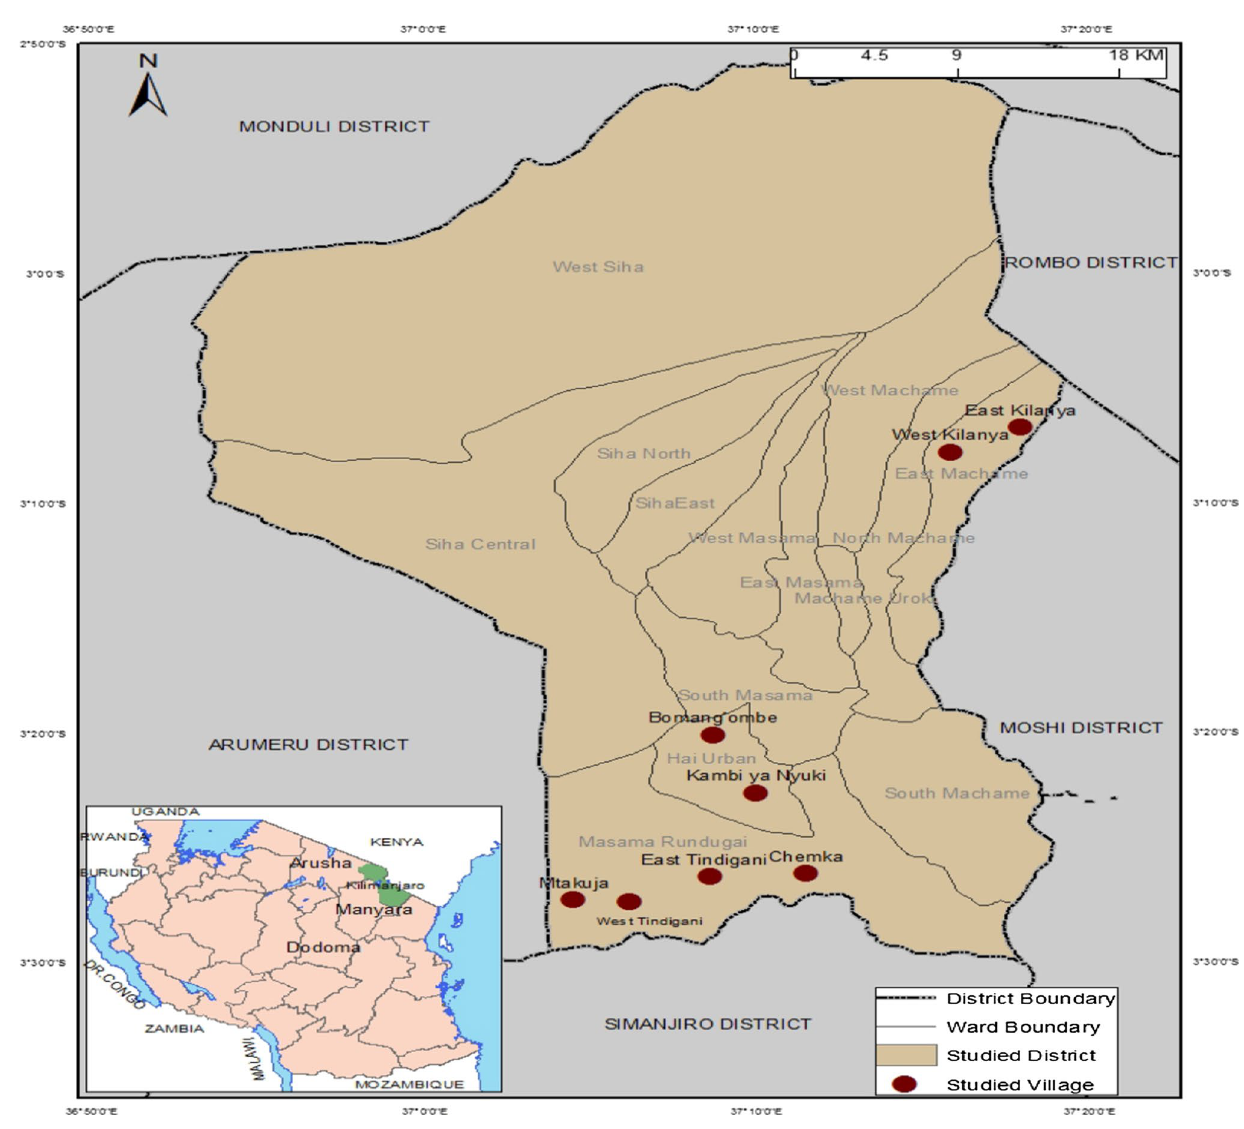
Fig. 1 Map of Hai District and its borders extracted from map of